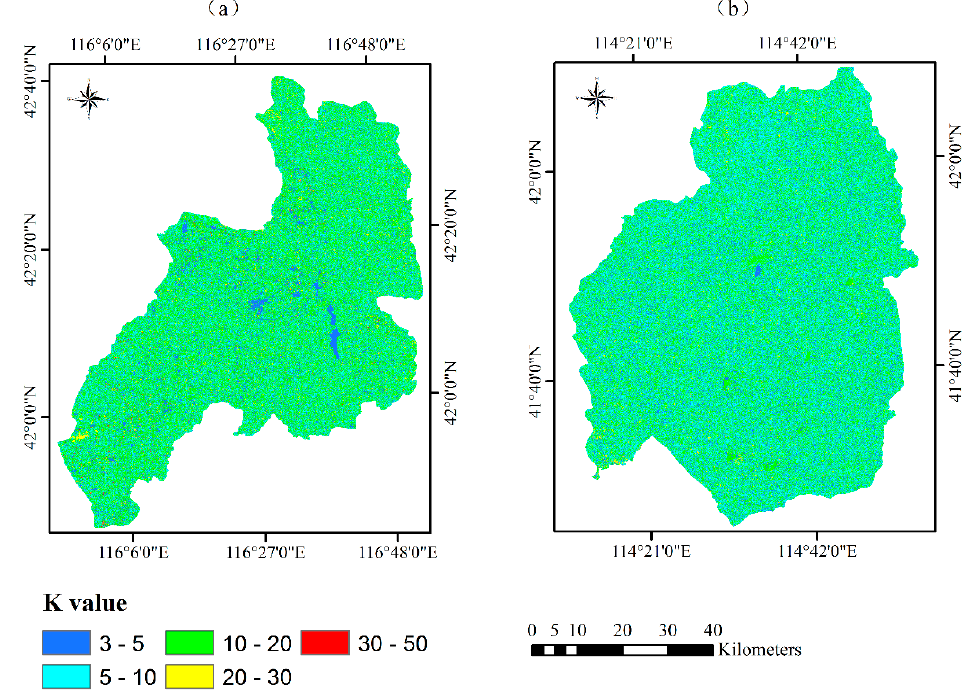
Figure 6. The spatial distributions of the optimal k (the optimal numbers of the nearest plots used) for predicting PVC at each location of ( a ) Duolun County and ( b ) Kangbao County using Opt_kNN.